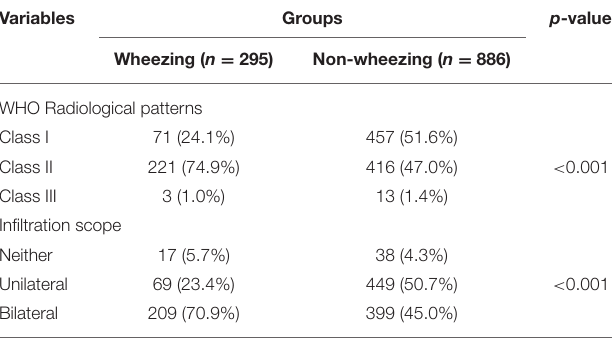
TABLE 4 | Chest radiographs of MP-infected children with and without